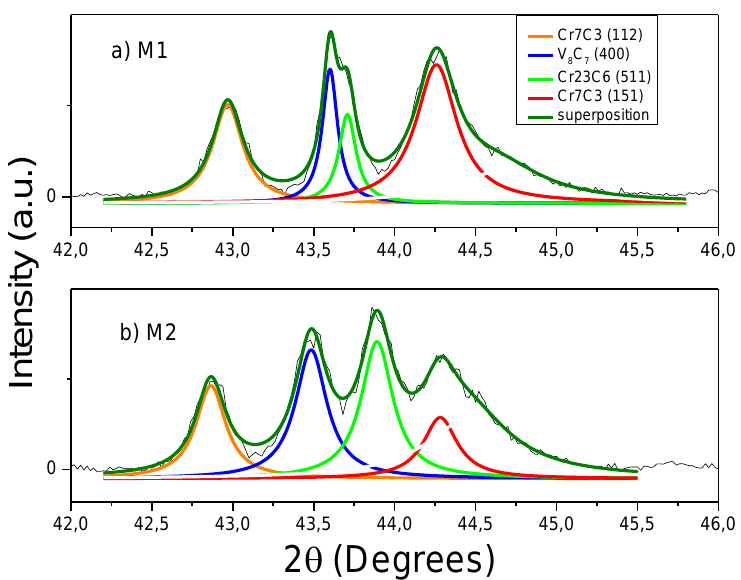
Figure 4. Deconvolution of the XRD patterns for samples ( a ) M1 and ( b ) M2.